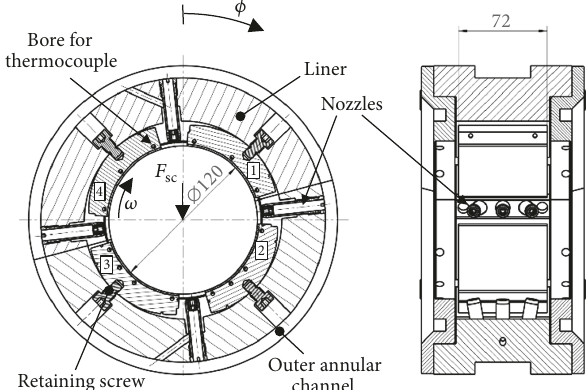
Figure 2: Tilting-pad bearing (TPB120).